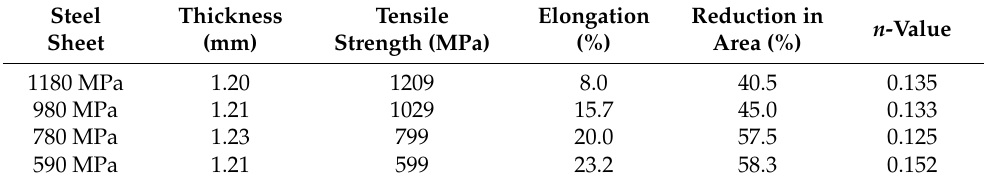
Table 1. Mechanical properties of steel sheets.